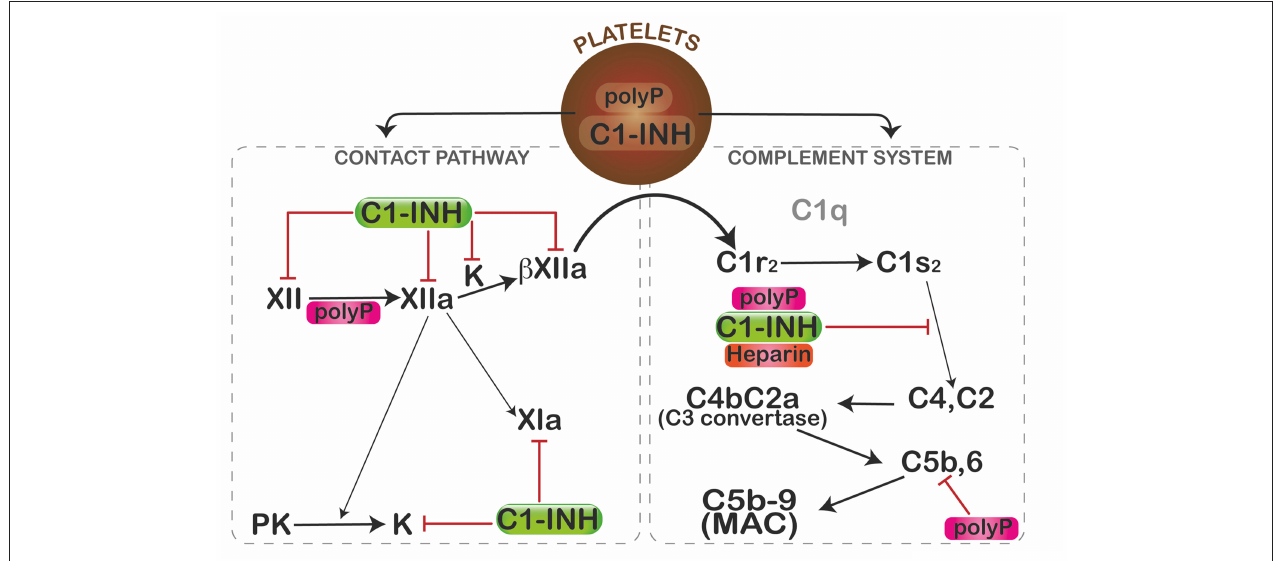
FIGURE 2 | Mechanisms by which polyP regulates complement activation. In resting platelets, polyP and C1-INH are housed in different organelles. After activation, polyP and C1-INH coalesce toward the center of the platelets where they colocalize and are subsequently secreted ( 66). PolyP triggers a conformational change in factor XII, resulting in generation of XIIa, which can activate prekallikrein (PK) and/or factor XI to XIa. Kallikrein (K) or plasmin (not shown) can further cleave XIIa to generate β XIIa which may activate C1r and thus promote complement activation. C1-INH dampens that pathway by inhibiting factor XII, XIIa, β XIIa, and kallikrein (K). C1s cleaves C4 and C2 to generate the C4b2a C3 convertase, which ultimately leads to formation of the C5b,6 complex, and assembly of the C5b-9 membrane attack complex (MAC). PolyP or heparin potentiate the inhibitory function of C1-INH via direct interactions with C1-INH and the target protease, C1s. PolyP also destabilizes C5b,6, thereby dampening formation of the MAC. Interestingly, in spite of binding to factors XIa and XIIa, reduced levels or function of C1-INH do not cause thrombosis, possibly due in part to differential effects of polyanions (polyP, heparin) on the function of the target enzymes. The over-riding effect of polyP in a serum-based endothelial cell culture system is to suppress complement activation. Figure and legend from Wijeyewickrema et al.